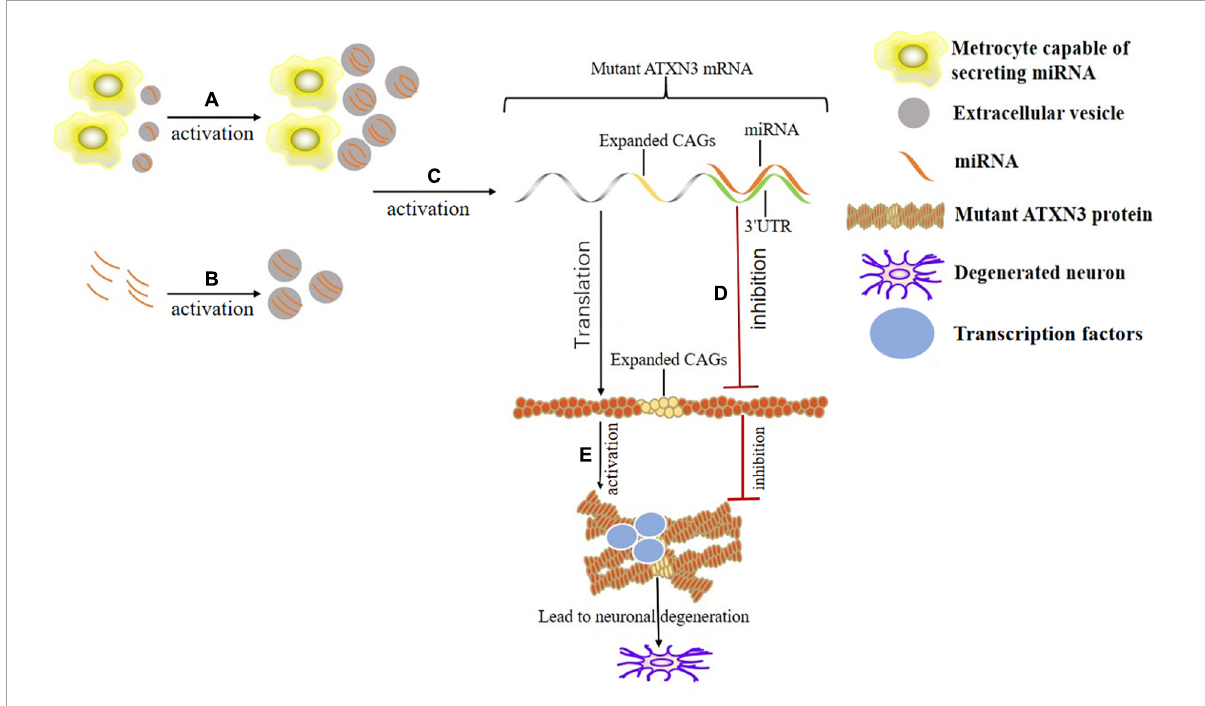
FIGURE2 Mechanism of the binding of EVs and miRNA in the treatment of SCA3. (A) Appropriately stimulate the specific metrocyte (such as hypoxia treatment) to maximize the therapeutic value of EVs derived from it. (B) Load the desired miRNA into the isolated and purified EVs through electroporation, incubation or ultrasound, etc. (C) EVs with specific miRNA acts on corresponding miRNA sites (there are 1,137 known sites presently) in the 3’UTR of mutant ATXN3 mRNA. (D) The mutated ATXN3 mRNA that binds to the miRNA in the 3’UTR region is degraded or its translation is inhibited. (E) Misfolding and aggregation of the mutated ATXN3 protein occur. Transcription factors are adsorbed by protein aggregates, interfering with the expression and biogenesis of normal miRNA. Eventually the neurons